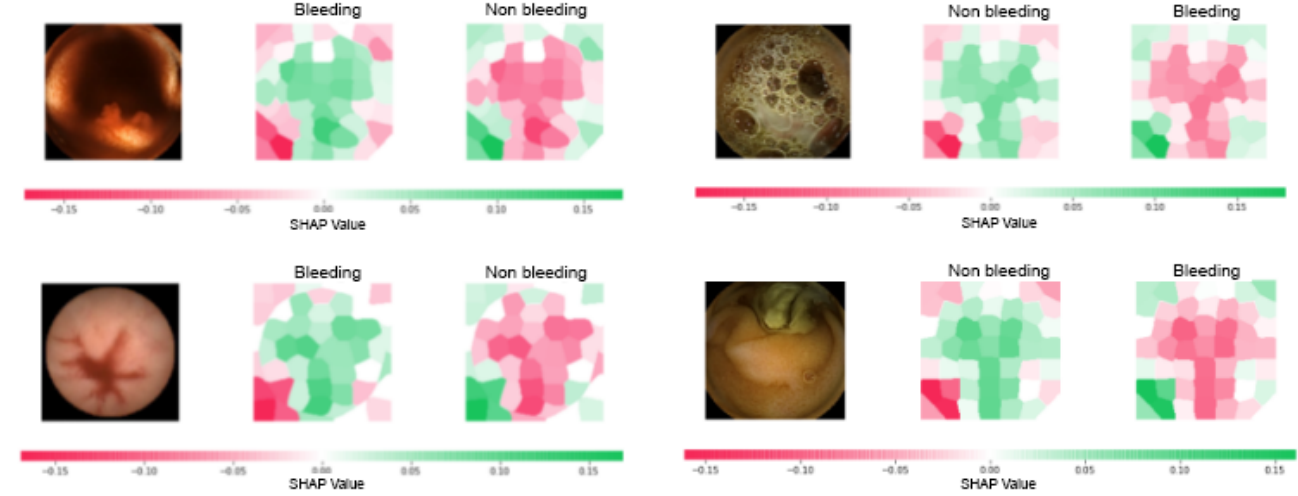
Figure 11. A few examples of SHAP explanations produced from the same input data as in the cases of LIME and CIU.